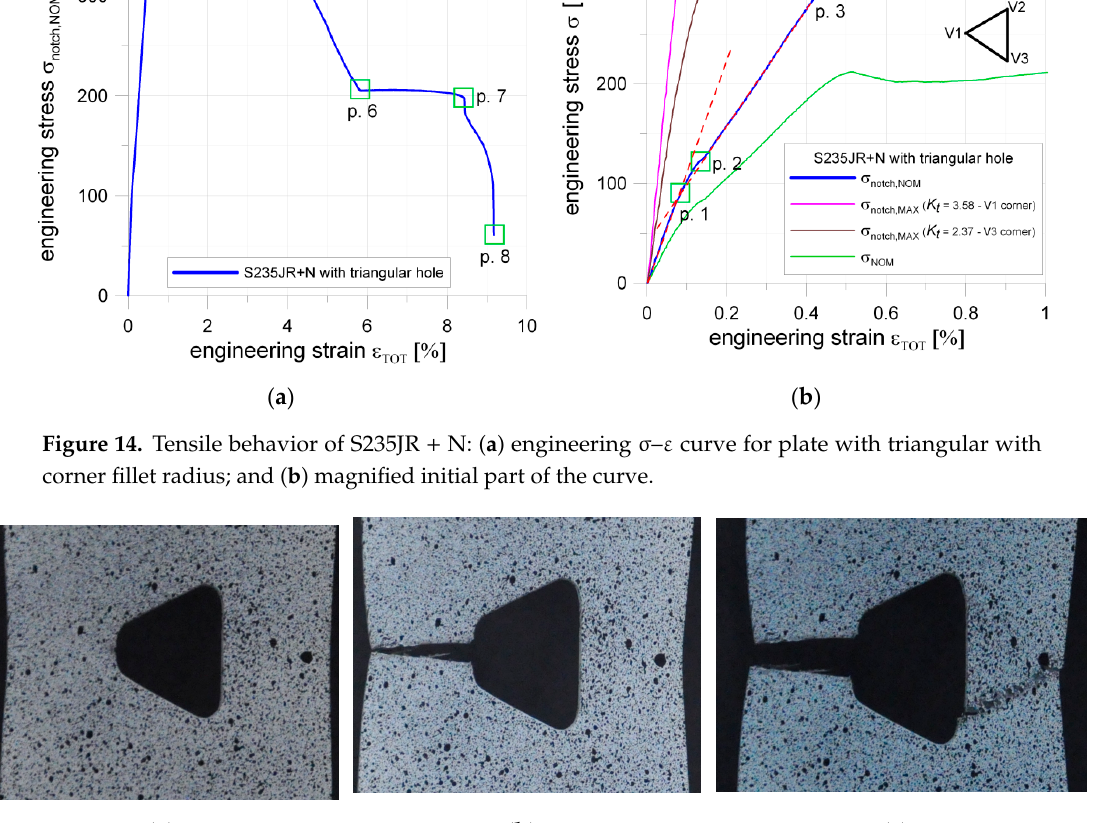
Figure 15. Tensile behavior of plate with triangular hole made of S235JR + N: ( a ) Point 5; ( b ) Point 6; and ( c ) failure. The points are given in Figure 14.